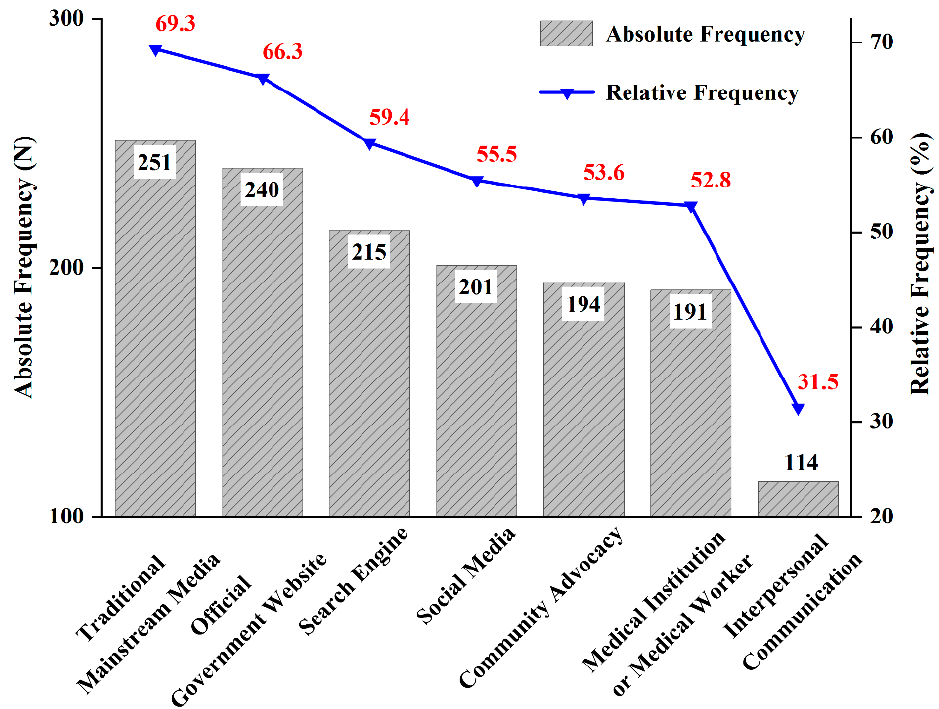
Figure 2. Participant’s choice of access to COVID-19 vaccine information.